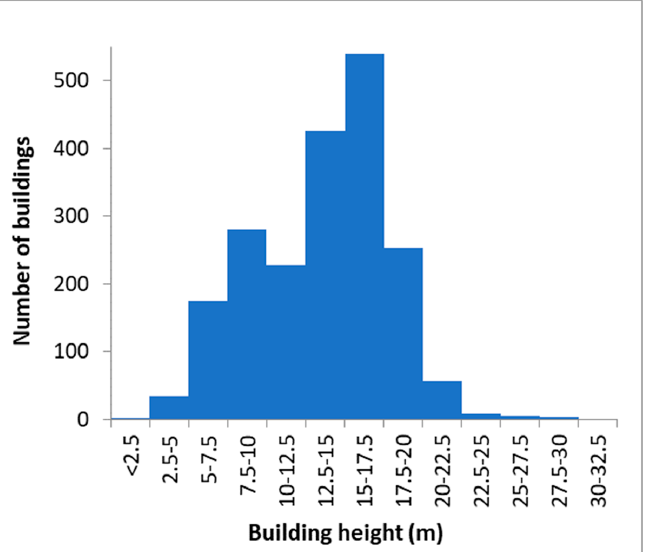
Figure 1. The histogram of building heights across the Dublin test area. The mean height is 12 m, but this masks a wide range of heights due to the range of buildings covering residential to com- mercial and Georgian to modern